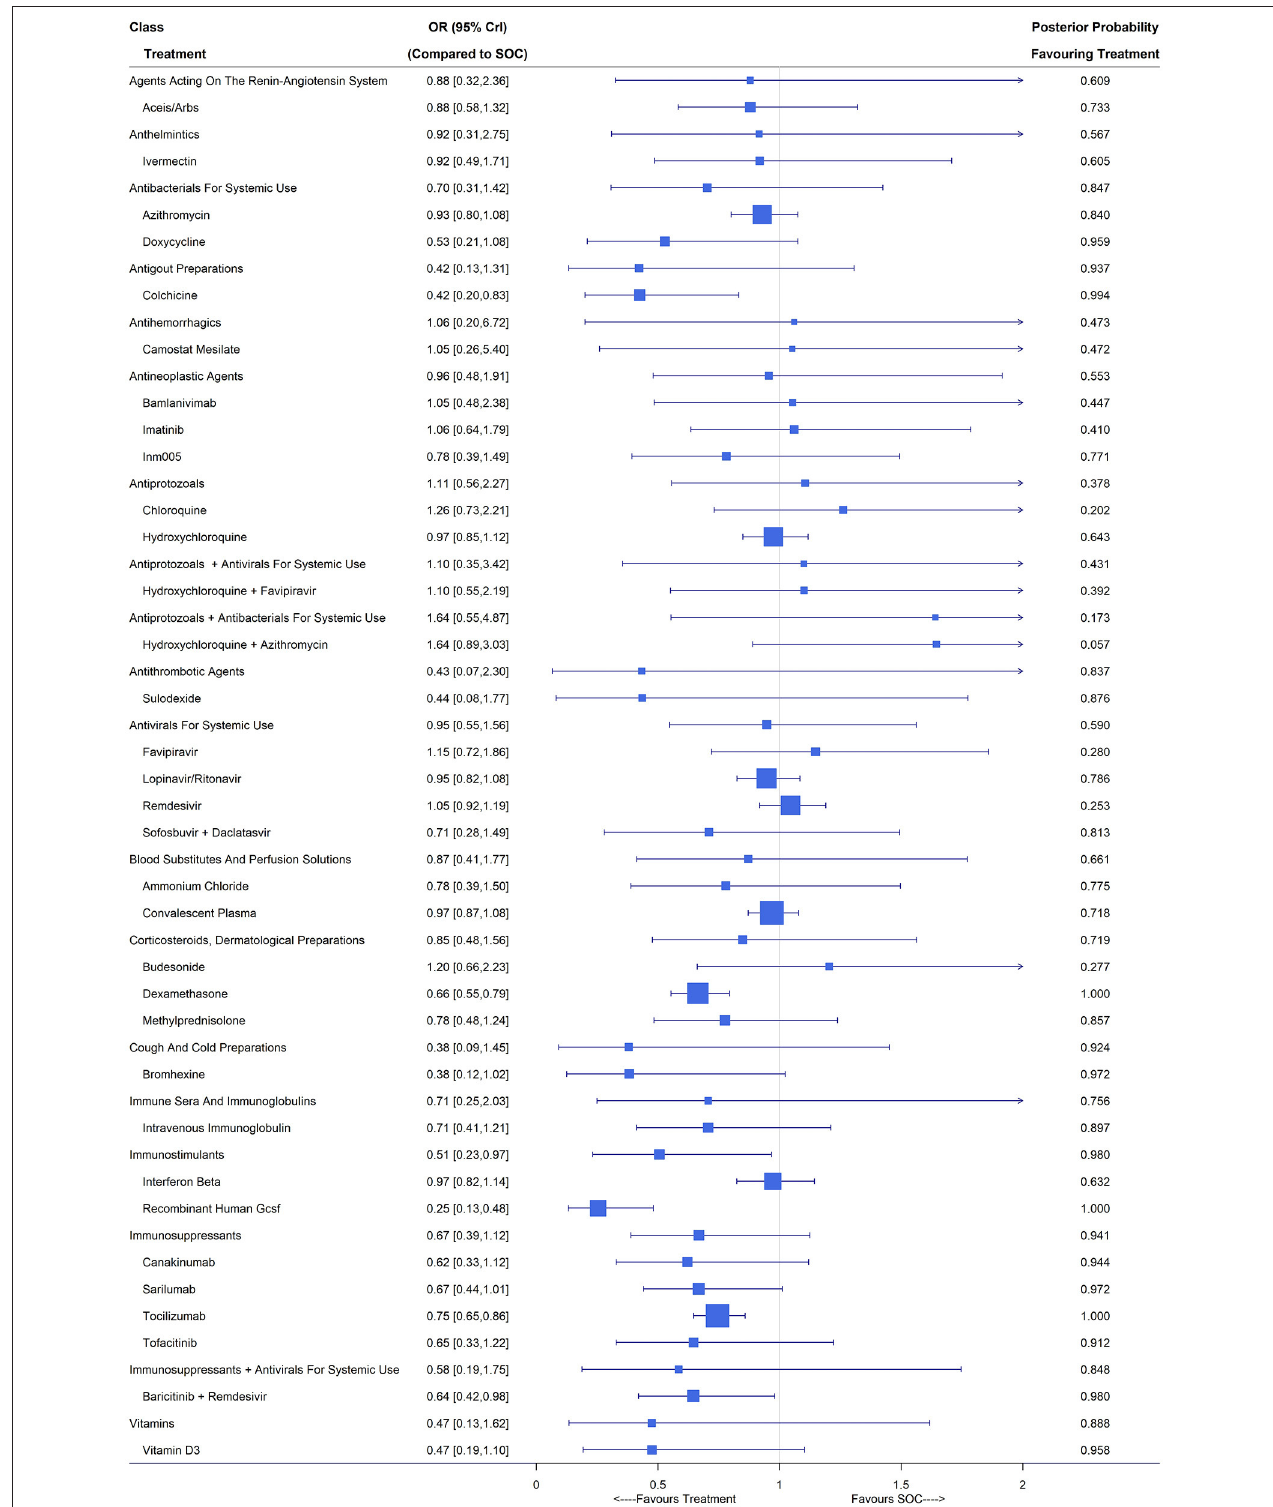
FIGURE 3 | Requirement of mechanical ventilation under treatments compared with the standard of care (SOC); OR is the odds ratio and CrI represents the credible interval.